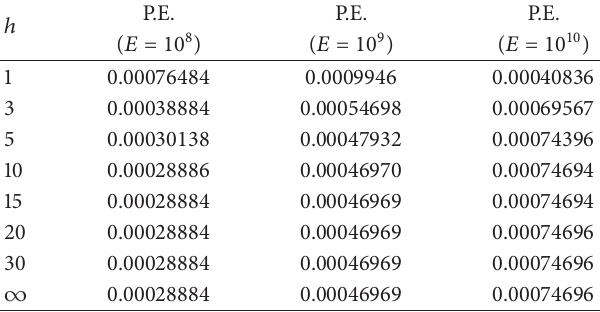
Table 3: P.E. for (44) with different values of Young’s modulus of the plate 𝐸 and various water depths ℎ